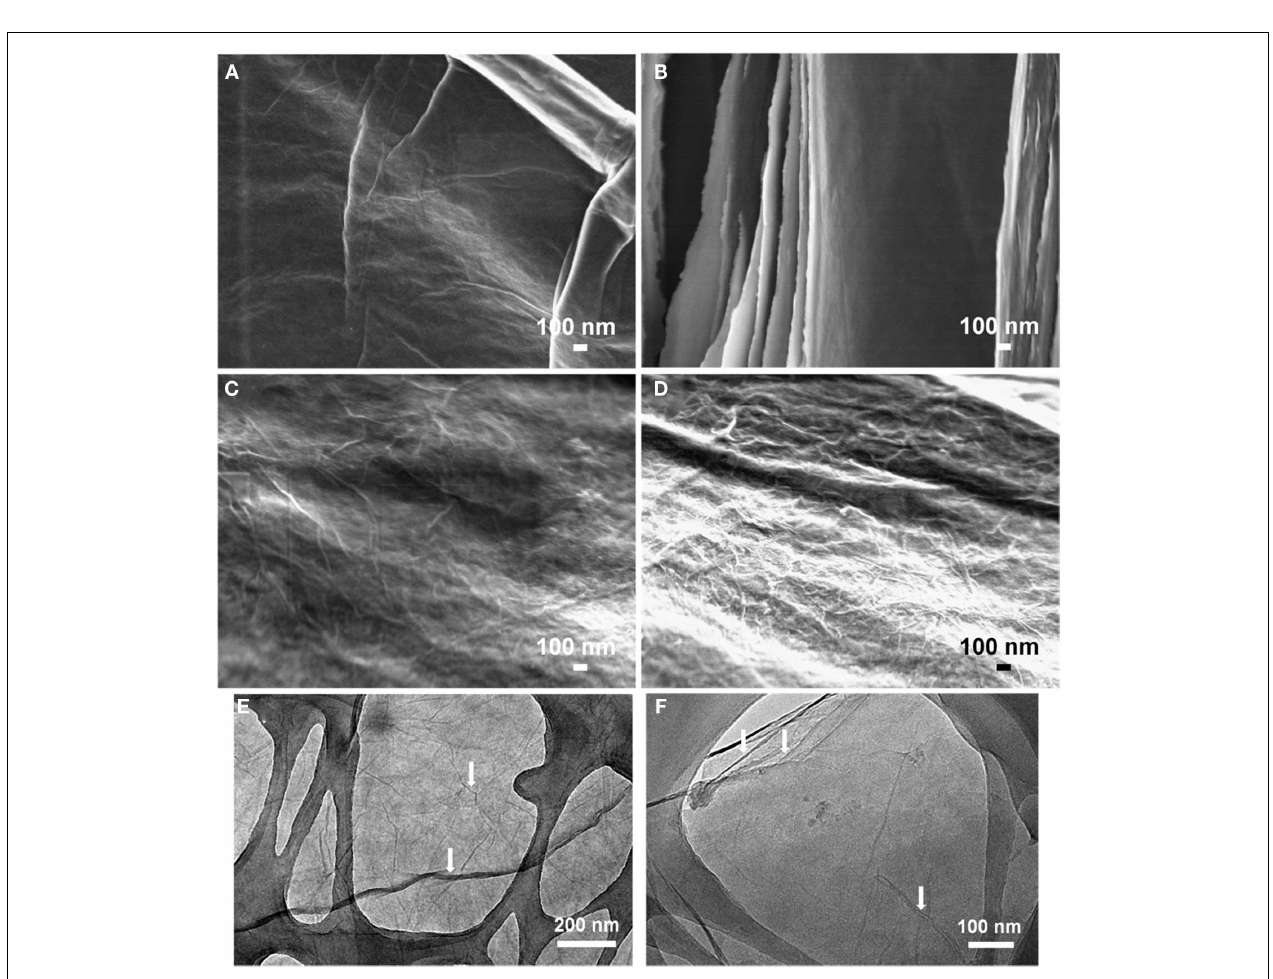
FIGURE 3 | Field emission scanning electron microscopy images showing the surface morphology of (A) GO, (B) GO-PP 25, (C) GO-PP 50, and (D) GO-PP 75. RepresentativeTEM images of (E) GO film and (F) GO-PP 25 composite